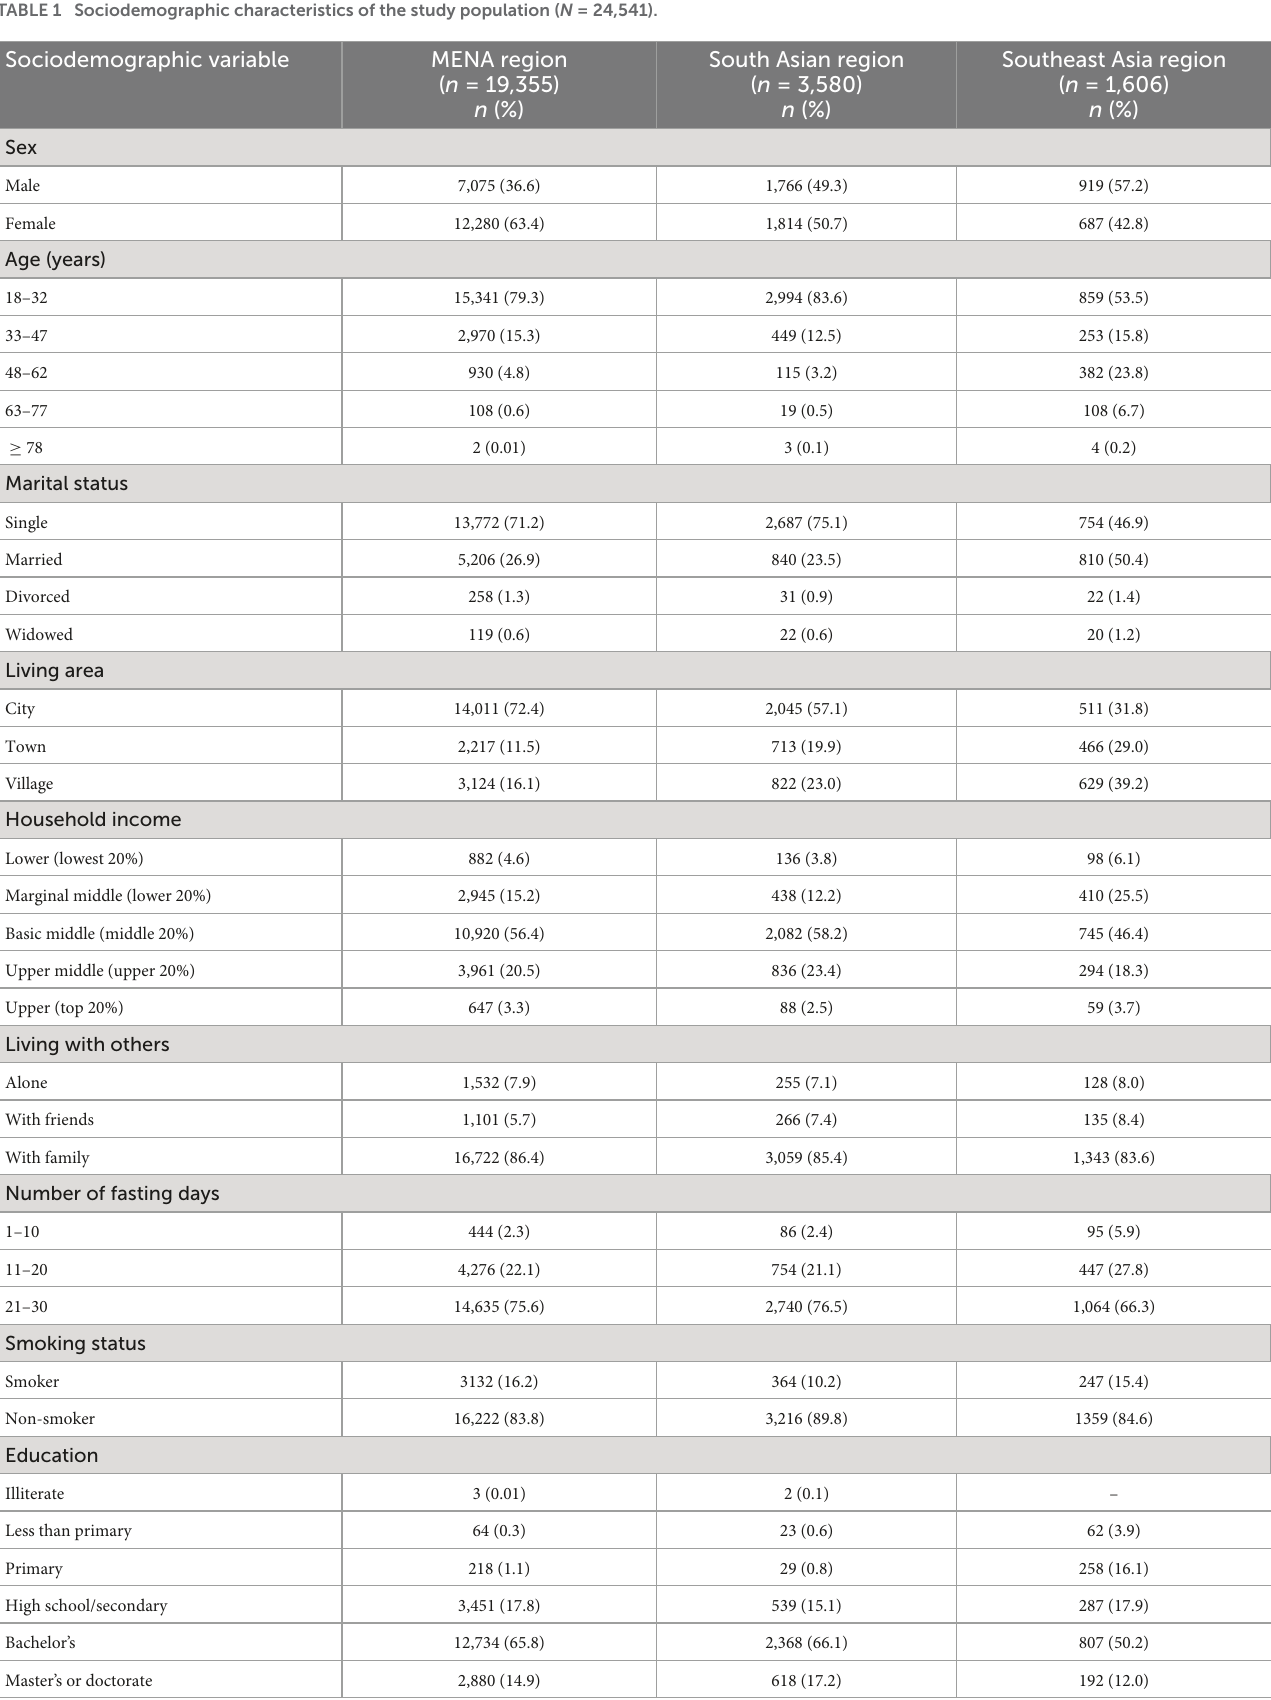
TABLE 1 Sociodemographic characteristics of the study population ( N = 24,541). Sociodemographic